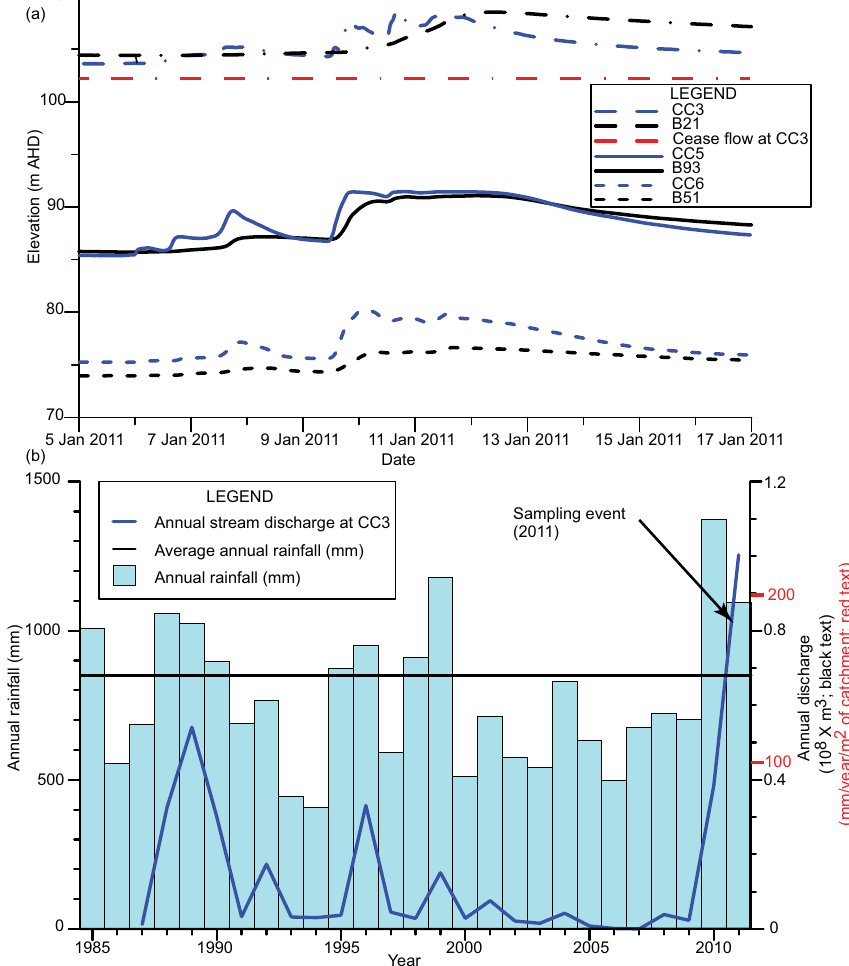
Figure 4. (a) Groundwater and stream hydrographs from the flood period; (b) annual rainfall (BOM, 2012) for the Cressbrook Creek catchment and annual stream discharge at CC3 (stream gauge 143921A; DNRM, 2012). Stream discharge is displayed in units of m 3 yr − 1 and mmyr − 1 m − 2 of catchment, assuming that the catchment area is 447km 2 . Also shown is time of sampling.